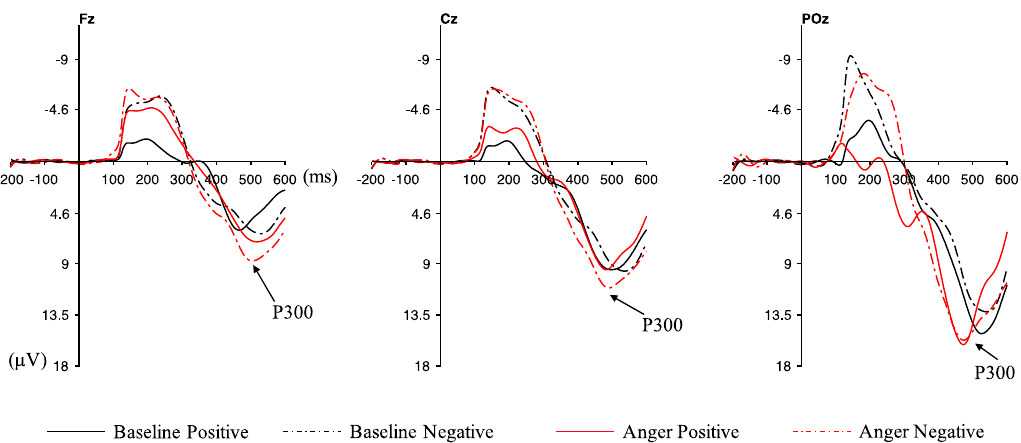
Figure 4. Waveforms of averaged ERPs for the positive and the negative feedback in the electrodes of Fz ( left ), Cz ( middle ), and POz ( right ). Note: The feedback stimulus onset occurred at time 0. P300 was calculated from 400 ms to 500 ms after the feedback onset. Negative was plotted up.